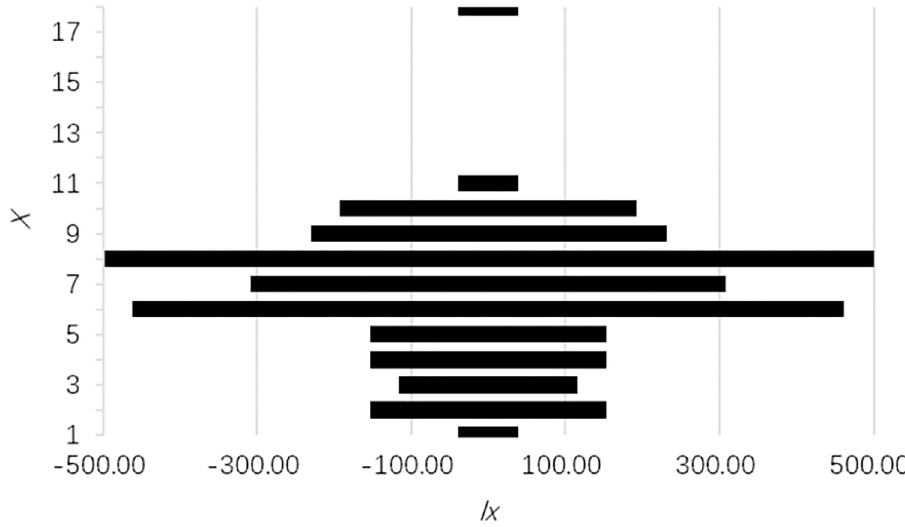
Fig 2. Age pyramid of P . flavus WM population.